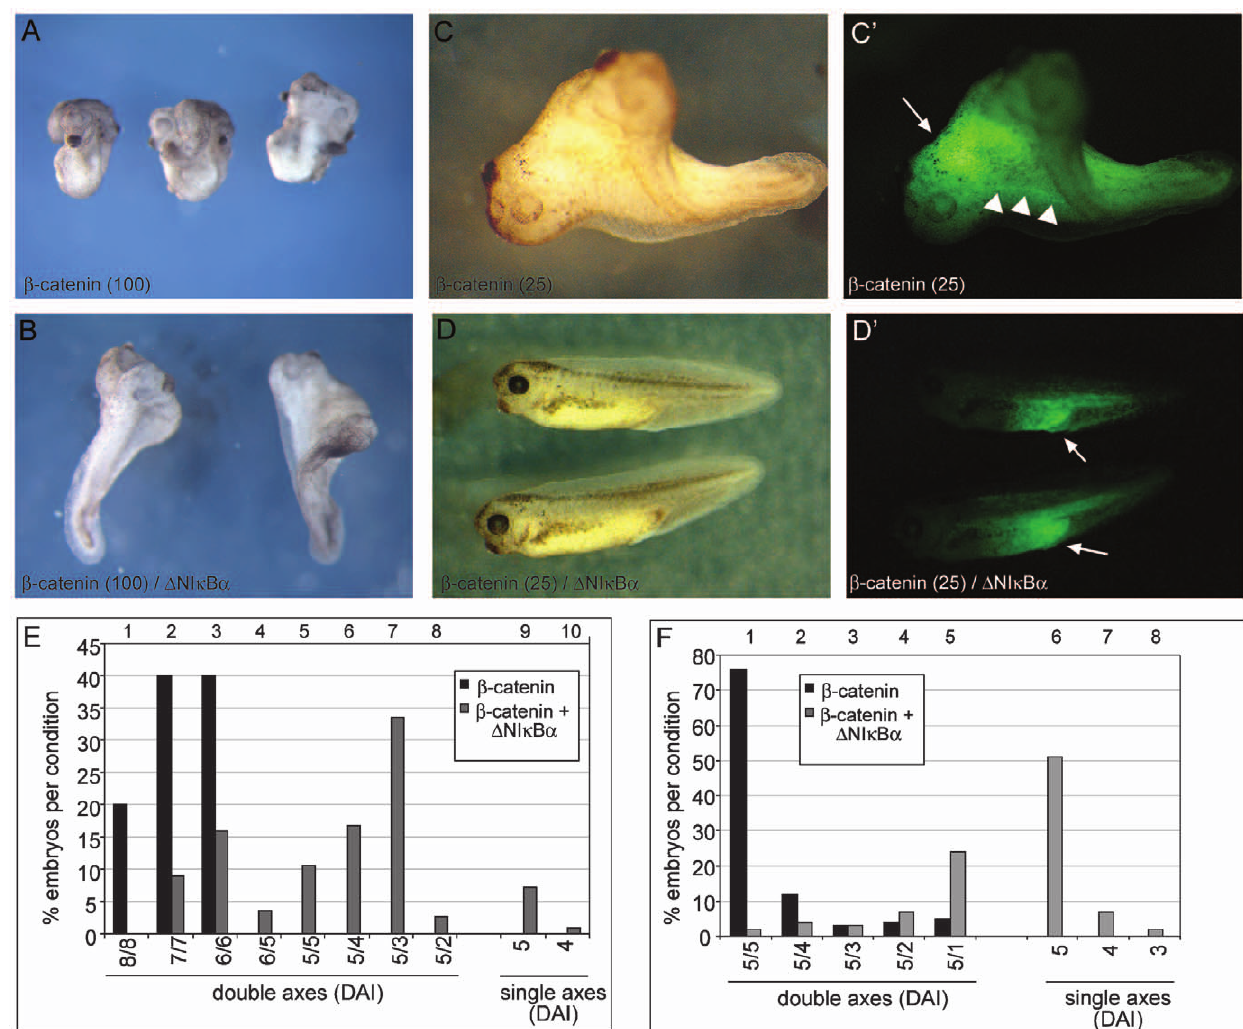
Figure 3. Dorsalisation by ectopic b -Catenin depends on endogenous NF- k B activity. Embryos were injected ventrally with high doses (100 pg, panels A,B ) or low doses (25 pg C,D ) of b -Catenin RNA, alone ( A,C ), or with 500 pg D NI k B a RNA ( B,D ). All injections included GFP RNA for lineage tracing (C 9 ,D 9 ). A ) Embryos injected with high b -Catenin RNA were highly dorsalized (average DAI 6.8 for each axis), almost always lacking posterior structures (n=160). B ) Co-injection of 500 pg of D NI k B a reduced the secondary axis to an average DAI=3.98, with a small number (8%) being single axis embryos (n=210). C ) The majority of embryos injected with low b -Catenin RNA produced pairs of complete axes, both of which scored as ‘‘5’’ on the DAI scale (n=155). D ) Coinjecting 500 pg of D NI k B a produced mostly single axis embryos (n=162). ( C 9 ,D 9 ) Lineage tracing showed that the b -Catenin RNA-injected cell progeny accumulated in the anterior region of one of the two axis (white arrow) with some posterior trailing in axial tissue (white arrowheads) ( C 9 ), while it was localized in posterior ventral tissues when D NI k B a was co-injected ( D 9 ). Panels E and F summarize the phenotypic penetrance for respectively high (100 pg) and low (25 pg) b -Catenin RNA (3 independent experiments in each case). Numbers on the X-axis indicate DAI-values of each embryonic Anlage (e.g. 5/5 defining a twinned embryo with two complete heads). where second axis formation by b -Catenin was inhibited through without affecting posterior tissues (see Figure 3C). Such secondary D NI k B a , green cells are found at a ventroposterior position axes were scored as 5 (‘‘normal’’ axis) on the DAI scale and made around the proctodeum (Figure 3D 9 ), corresponding to the normal up the majority of embryos injected with this lower dose of b - fate of cells derived from the ventral site of injection. The cells’ Catenin (Figure 3F). Co-injection of D NI k B a RNA led to a position, therefore, is correlated to their amount of dorsalizing significant quantitative and qualitative reduction of secondary axes activity, indicating that they are viable and capable of populating formed. In fact, the majority of embryos returned to a single axis different embryonic regions. Based on the observed antagonism, state under these conditions (Figure 3D and F, compare black we conclude that D NI k B a is capable of blocking b -Catenin versus grey columns). GFP lineage tracing shows that the progeny function during secondary axis formation, most likely through the of the injected blastomeres acquire specific positions within the observed interference with the expression of co-regulated target embryo dependent on the experimental condition. In cases of genes (see Figure 1). This effect is remarkably strong, since complete secondary axes, green cells localize to the anterior significant inhibition is observed even in the presence of very large endomesoderm with some posterior trailing along midline tissues amounts of b -Catenin mRNA. In contrast, formation of the (Figure 3C 9 ), consistent with their ‘‘Organizer’’ activity. In cases